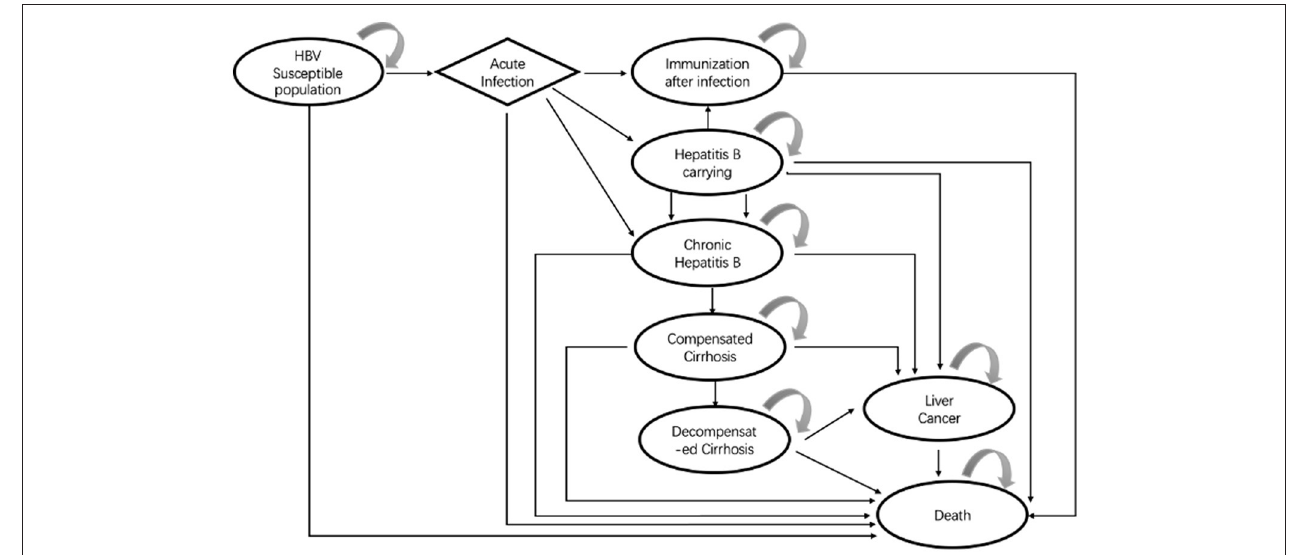
FIGURE 2 | Markov diagram after HBV